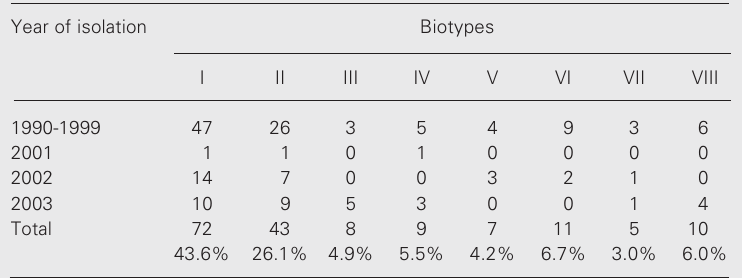
Table 2. Frequency distribution of biotypes of 165 Haemophilus influenzae strains isolated from 1990 to 2003. Year of